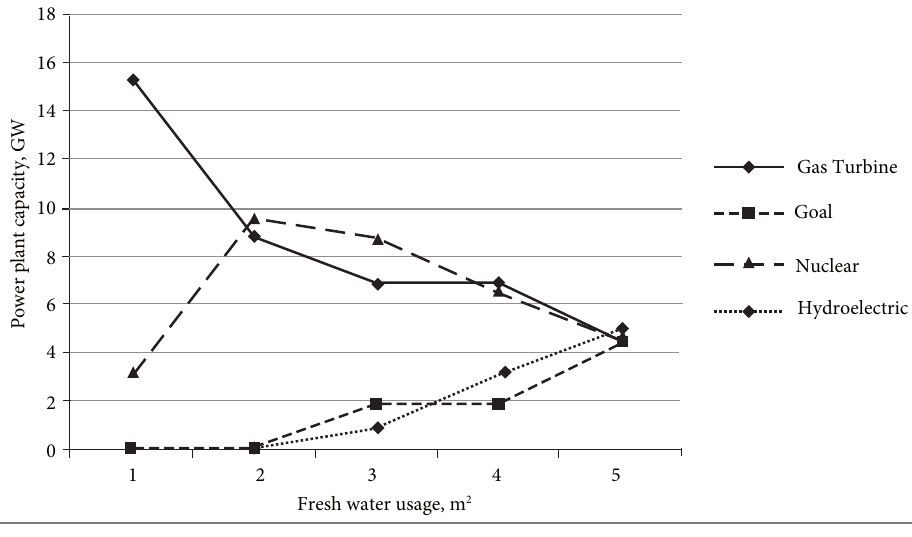
Fig. 5. Change of the power plant capacity optimal construction by fresh water